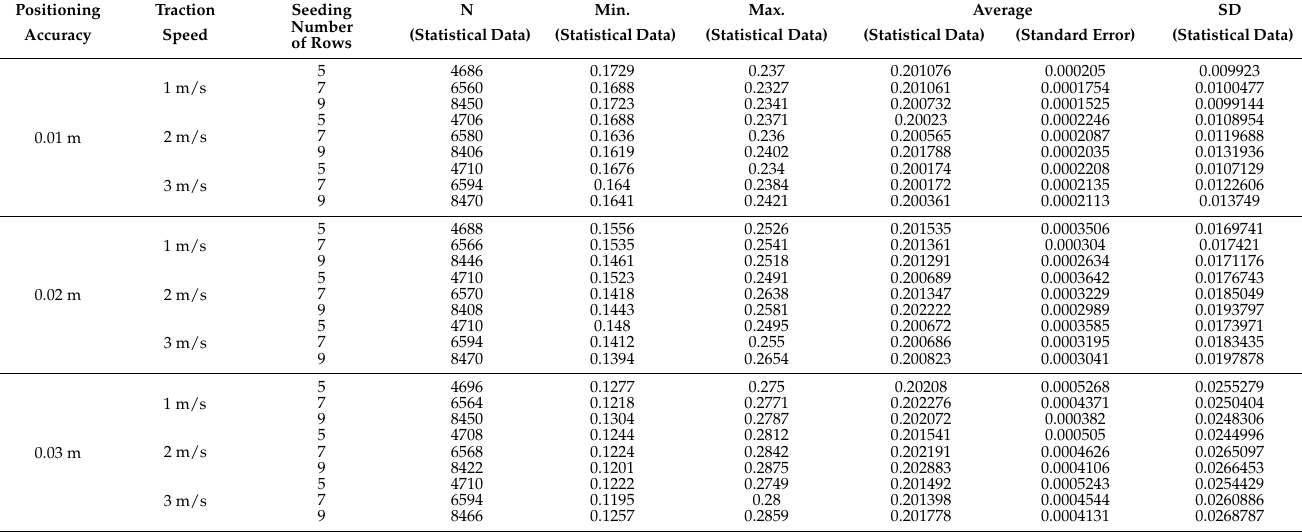
Table 2. Statistical Description of Simulation